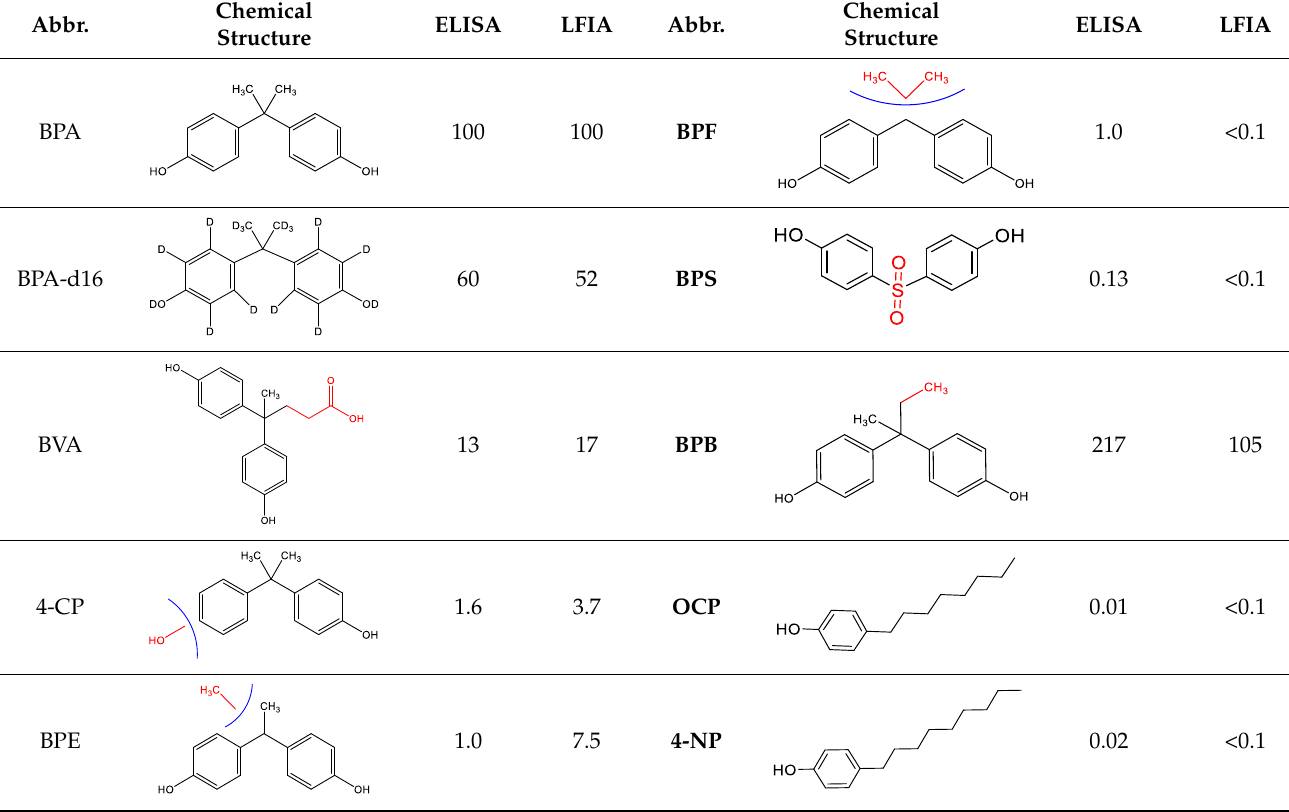
Table 2. Cross-reactivity (CR, in %) of the antibody, determined by LFIA. Abbr.